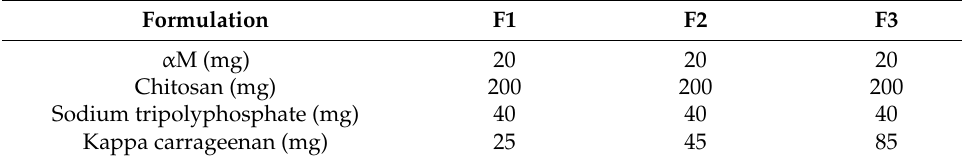
Table 1. α M polymeric nanoparticle